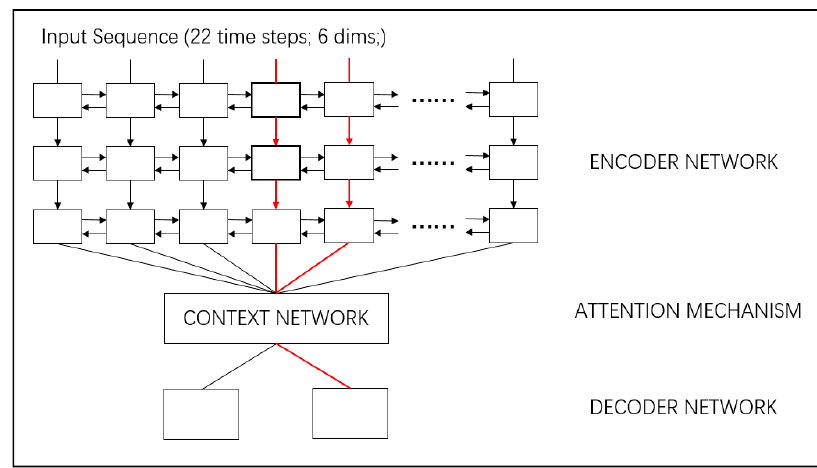
Figure 5. Overview of the A-LSTM architecture. The attention mechanism looks at the complete encoded sequence to determine the encoded steps to weigh highly and generates a context vector. The decoder network uses these context vectors to make a